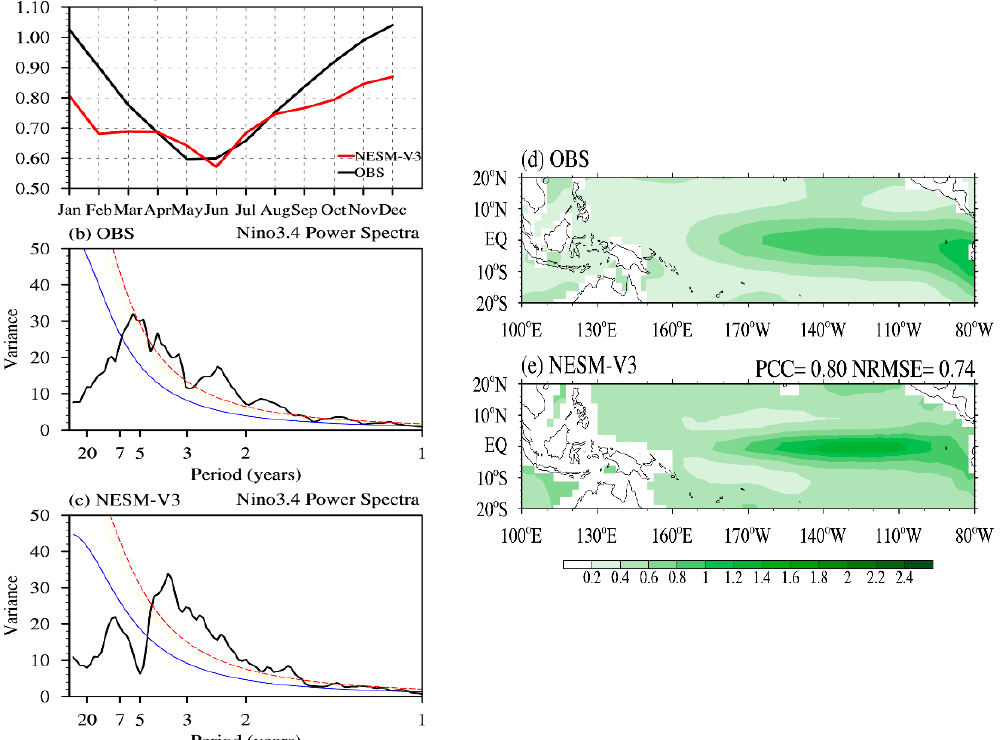
Figure 3. ( a ) Monthly standard deviation (STD) of Nino3.4 SST anomalies, and power spectra of Nino3.4 SST anomaly in ( b ) observation and ( c ) NESMv3. In ( b , c ), the blue lines indicate red noise, and the red dashed lines indicate the 95% confidence level. Interannual variance of ( d ) observed and ( e ) NESMv3 simulated monthly SST.